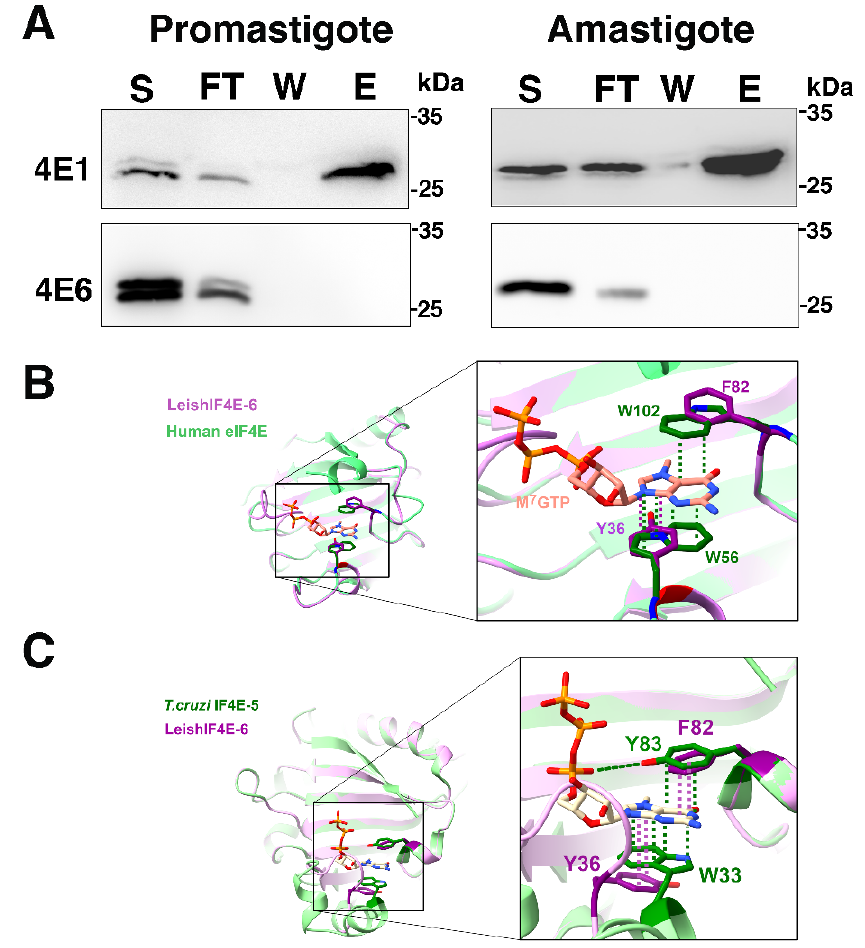
Figure 4. ( A ) LeishIF4E-6 does not bind the cap analog m 7 GTP in promastigotes and axenic amastigotes. Lysates of SBP-tagged LeishIF4E-6 overexpressing cells were obtained from promastigotes and axenic amastigotes. The lysates were incubated with m 7 GTP-agarose beads that were washed and further eluted with free m 7 GTP (200 µ M). The eluted proteins and wash fractions were precipitated with 10% TCA for further analysis over SDS-PAGE (12%). The gels were loaded with samples from the total supernatants (S, 2%), flow-through fractions (FT, 2%), the final wash fractions (W, 50%) and the eluted fractions (E, 50%). The blots were analyzed using monoclonal antibodies against the SBP-tag (fused to LeishIF4E-6) and against LeishIF4E-1 that served as a positive control for m 7 GTP binding in the same extracts. Similar results were obtained from three independent experiments; ( B ) structural differences in the predicted m 7 GTP binding pocket between the human eIF4E and LeishIF4E-6. The LeishIF4E-6 homology model (purple) was superposed on the human eIF4E (PDB: 5T46, green). The different amino acids in the cap-binding pocket are represented as sticks, with oxygen atoms in red, nitrogen in blue and phosphates in orange. The π stacking interactions between m 7 GTP and the aromatic residues are shown as dashed lines in colors that correspond to the aromatic residues from the different organisms (human in green and Leishmania in purple); ( C ) structural differences in the predicted m 7 GTP binding pocket between the LeishIF4E-6 and T. cruzi IF4E-5. The LeishIF4E-6 homology model (purple) was superposed on the T. cruzi IF4E-5 (PDB: 6O80, green). The different amino acids in the cap- binding pocket are represented as sticks, oxygen in red, nitrogen in blue and phosphate in orange. The π stacking interactions between m 7 GTP to the aromatic residues are shown as square dotted lines in suitable colors. The hydrogen bond between Y83 (green) and the m 7 GTP phosphate oxygen is represented by elongated dotted lines in the suitable color.